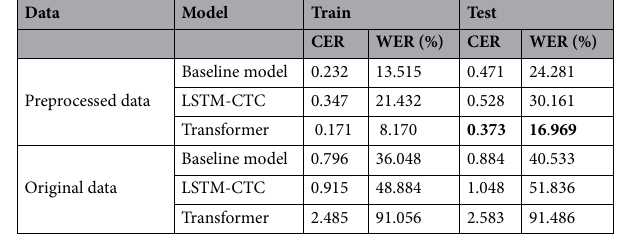
Table 8. Experimental results of different model comparison. Significant values are in [bold].